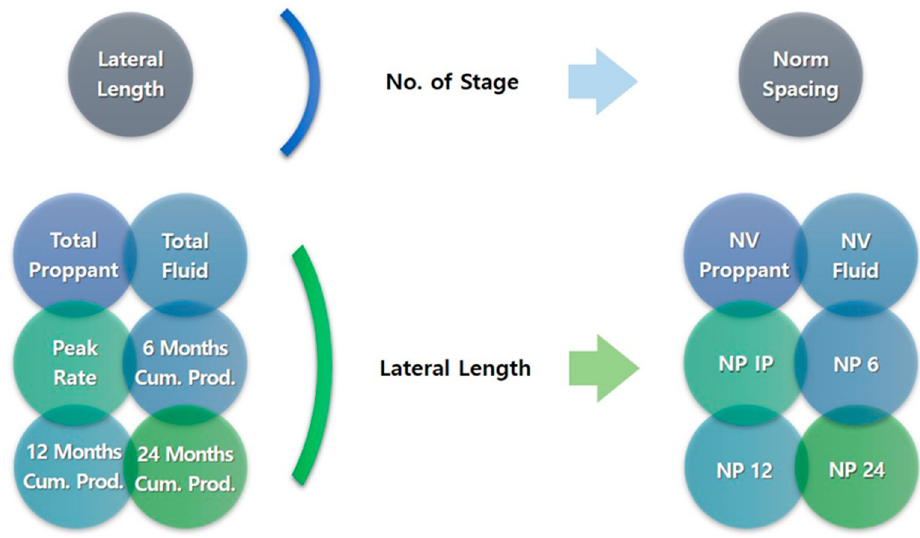
Figure 4. Data preprocessing for shale formations.